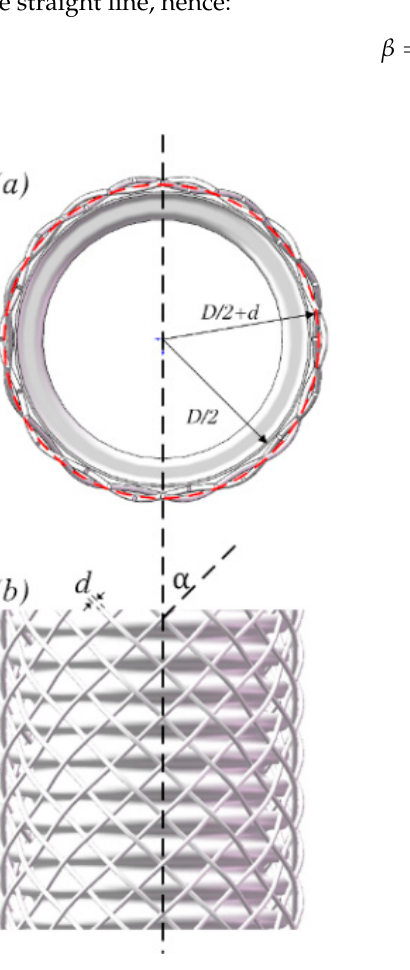
Figure 1. Parametric model of the braided corrugated hose: ( a ) top view; ( b ) side view.